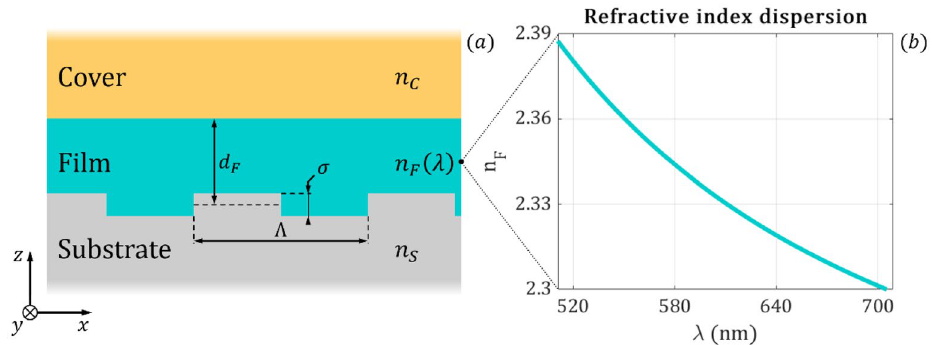
Figure 1. (a) The cross-section of the modeled corrugated waveguide. The electromagnetic simulations apply Floquet boundary conditions along the x- and y-axis and open boundaries with Floquet ports in the vertical z direction. (b) The frequency dependence of the Nb 2 O 5 film refractive